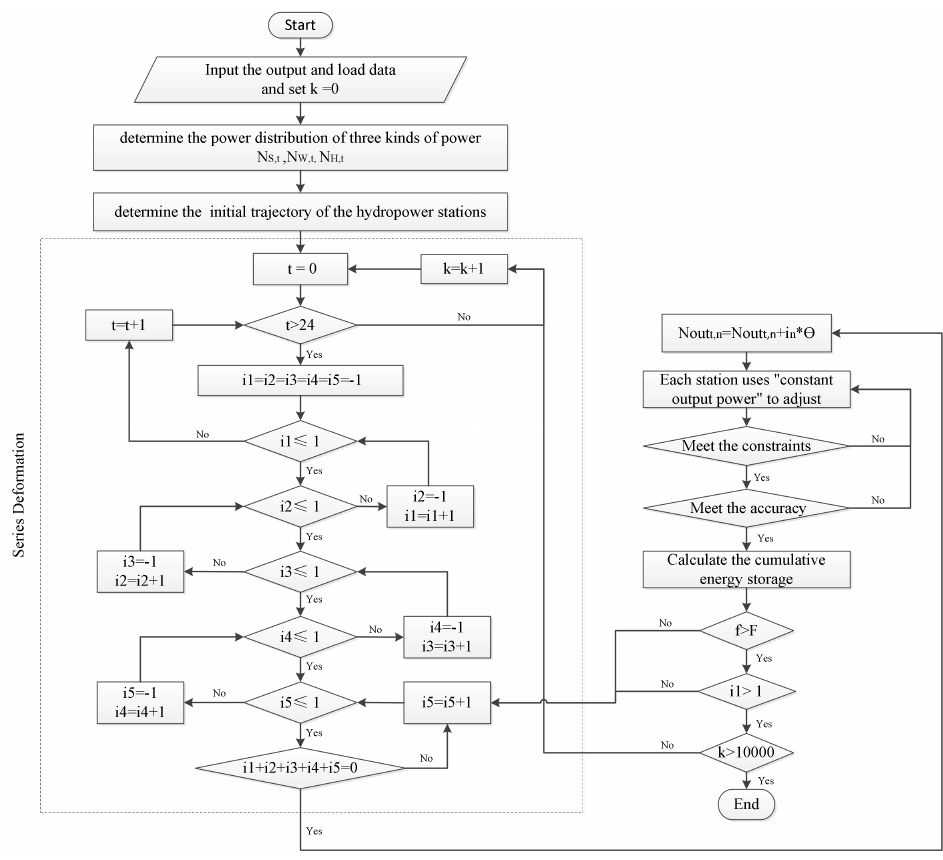
Figure 6. Flow chart through the overall solution